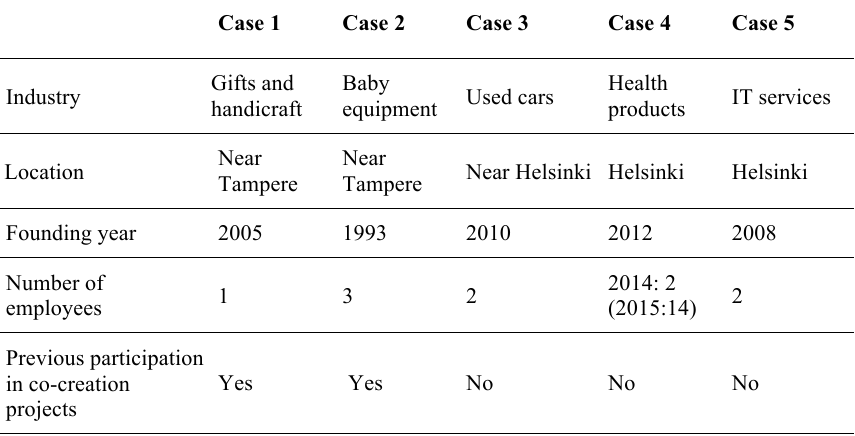
Table 1 lists background information of the cases. Table 1. Background information of the